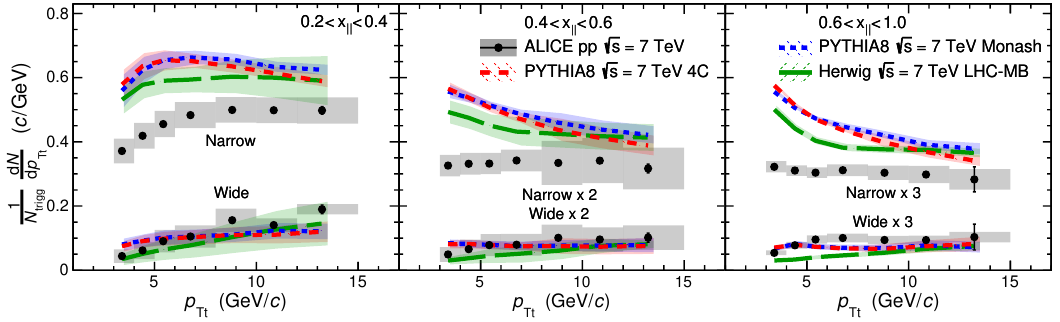
p Figure 7 . Yields of the narrow and wide j T components for pp collisions at s = 7 TeV (circular symbols) compared to Pythia 8 tunes 4C (dashed line) and Monash (short dashed line), and Herwig 7 LHC-MB tune (long dashed line) at the same energies. Di(cid:11)erent panels correspond to di(cid:11)erent x bins with 0 : 2 < x < 0 : 4 on the left, 0 : 4 < x < 0 : 6 in the middle, and 0 : 6 < x < 1 : 0 k k k k on the right. The statistical errors are represented by bars and the systematic errors by boxes. q (cid:10) (cid:11) The narrow component j 2 results from three x bins are compared to the k T